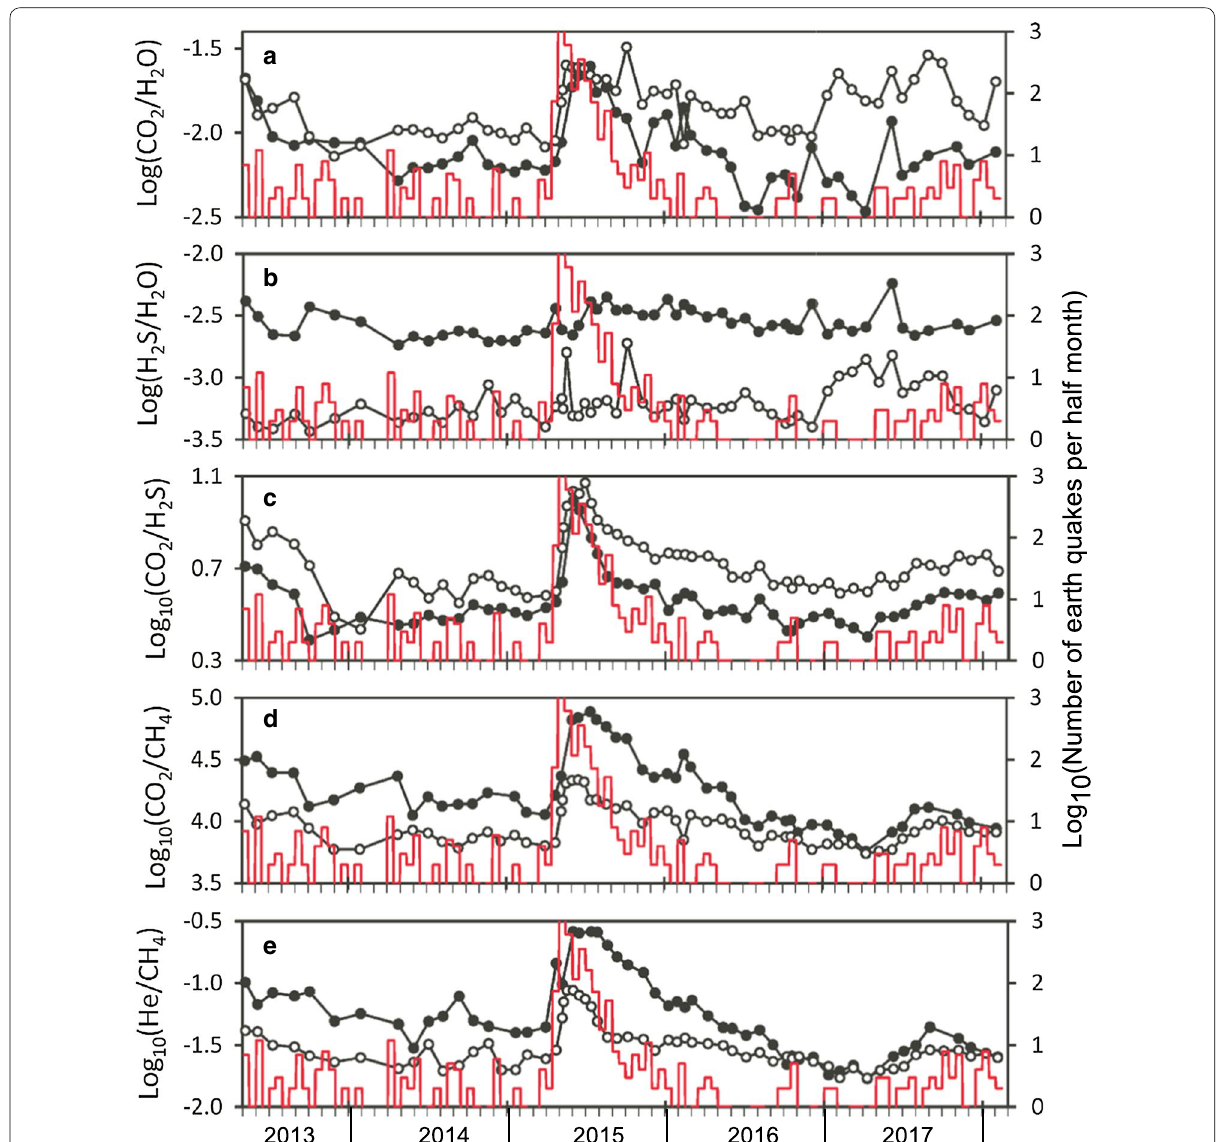
Fig. 2 Time variation of CO 2 /H 2 O, H 2 S/H 2 O, CO 2 /H 2 S, CO 2 /CH 4 and He/CH 4 in fumarolic gases. Solid and open circles indicate the values for the fumarole N and S, respectively. Red curve indicates the number of earthquakes per half month observed at Hakone